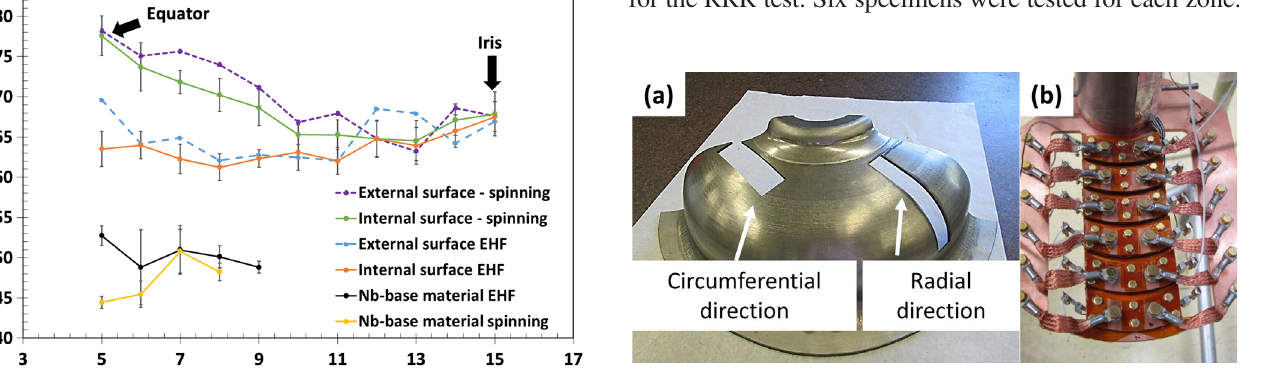
FIG. 10. Vickers hardness (HV 10) measured on the external and internal surfaces for half-cells formed by spinning and EHF.